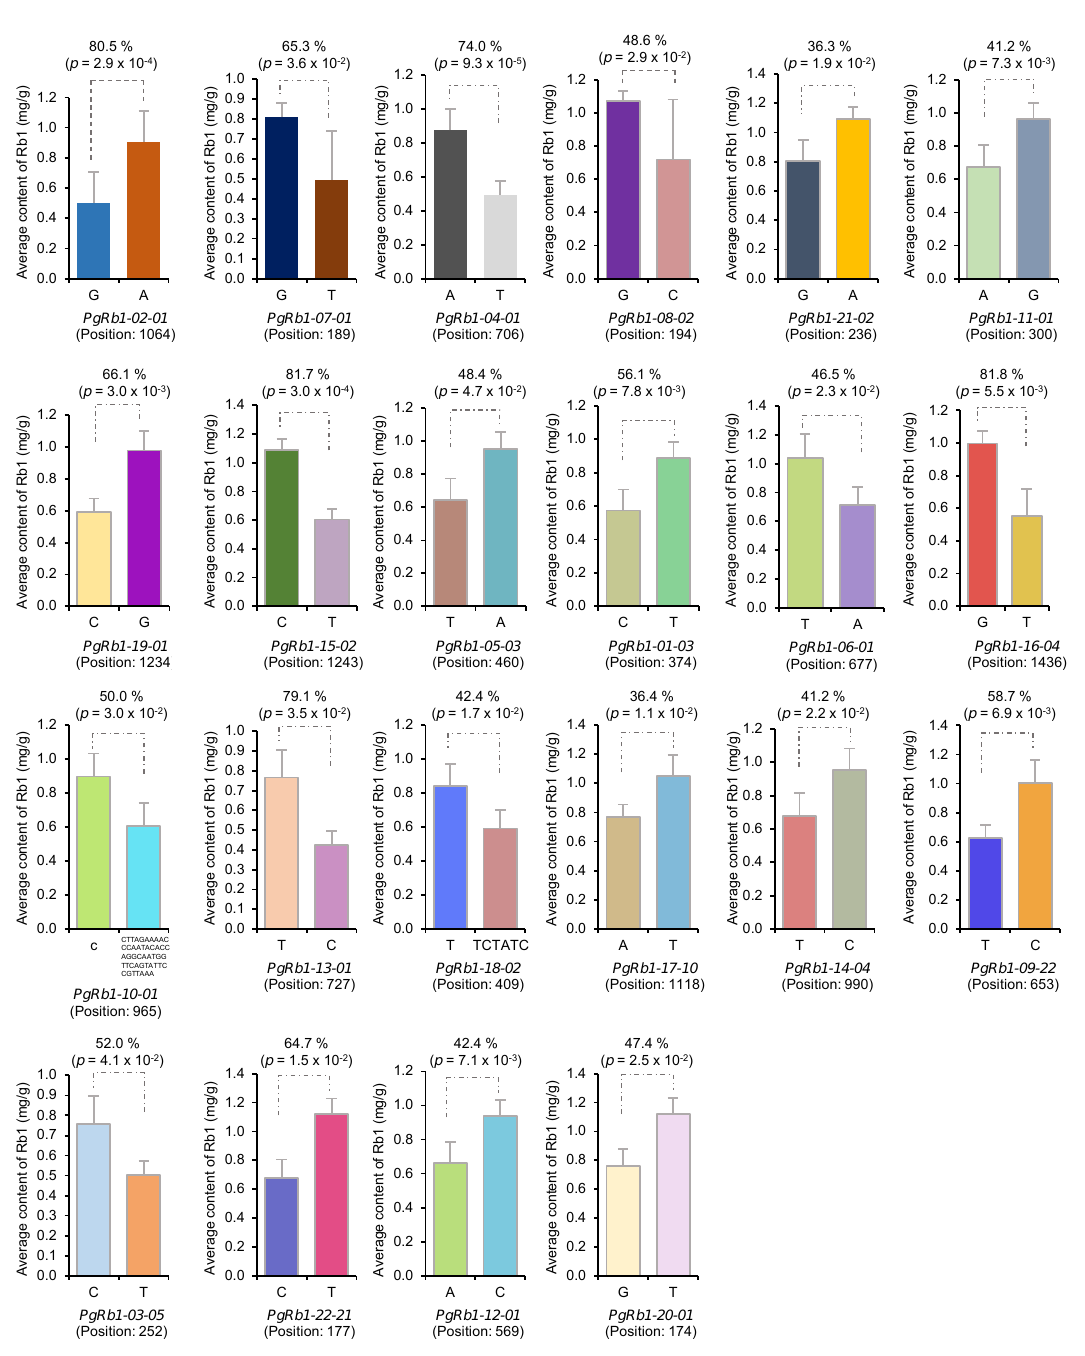
22 candidate gene DET-IIIs for Rb1 biosynthesis. All